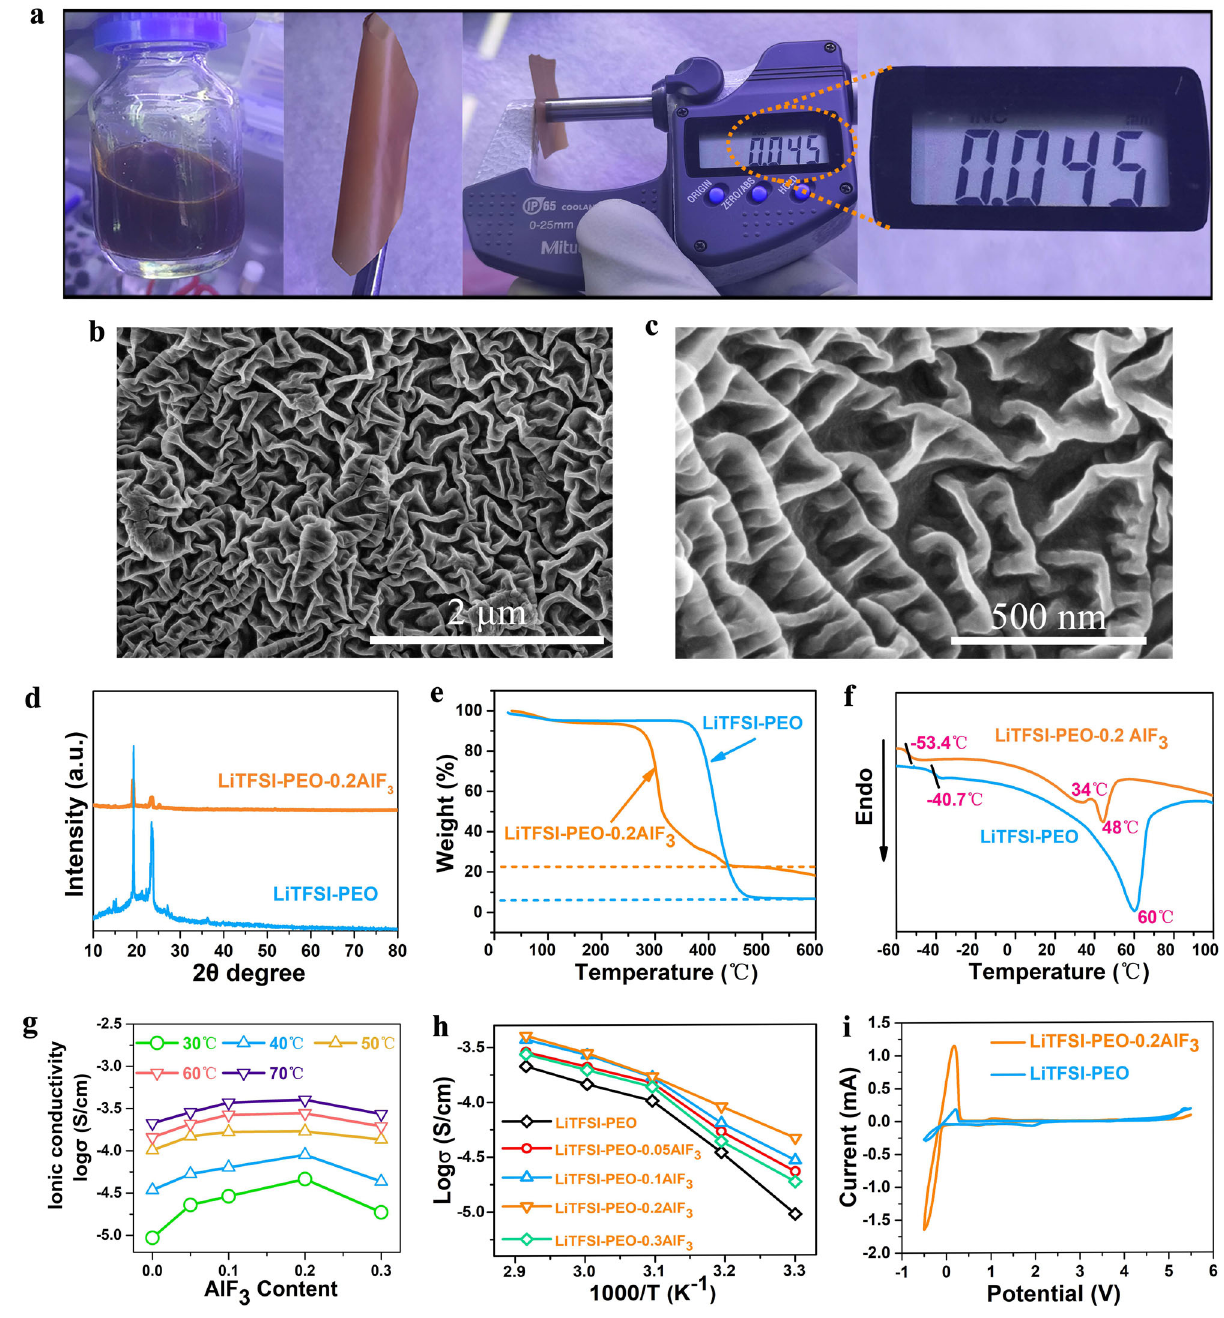
and LiTFSI-PEO membranes. g Ionic conductivity measurements of solid polymer electrolytes by two-electrode Swagelok-type SS|LiTSFI-PEO-AlF 3 |SS cell con fi gura- tion with different amounts of HS-AlF 3 fi ller in different testing temperatures ran- ging from 30 to 70°C. h Arrhenius plots of corresponding AlF 3 -reinforced composite membranes. i CV curves of Li|LiTFSI-PEO-0.2AlF 3 |SS and Li|LiTFSI-PEO| SS cells at a scan rate of 0.5mV/s at